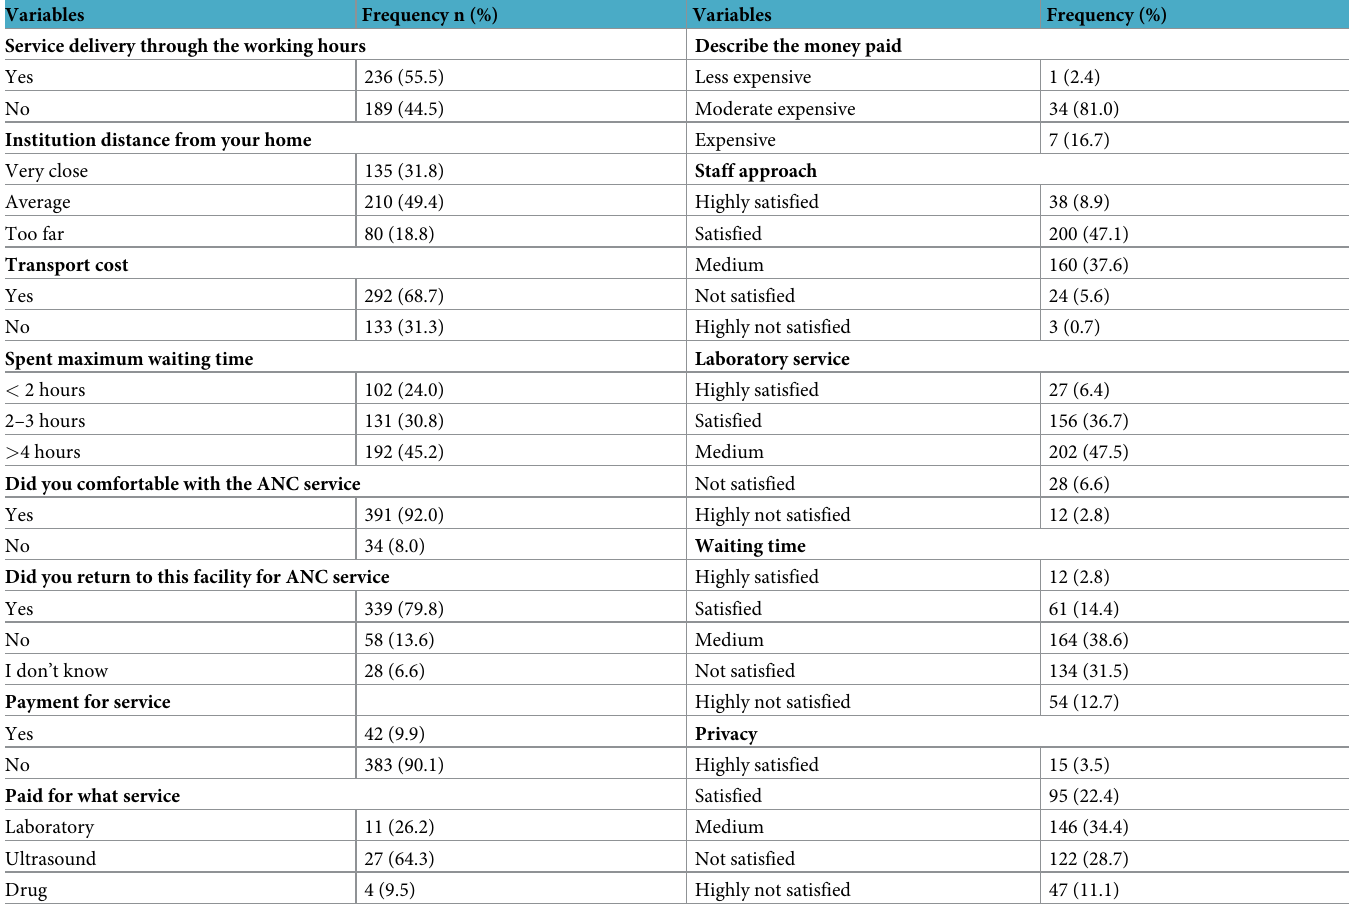
Table 5. Health service- related factors in Mizan-Aman town, southwest Ethiopia